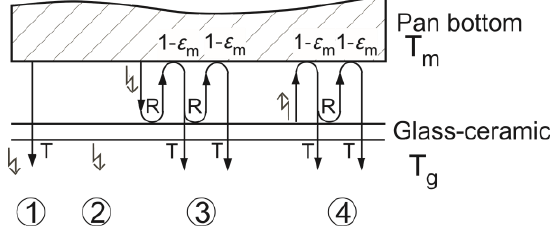
Figure 2. The four components of the thermal radiation of pan bottom/glass-ceramic